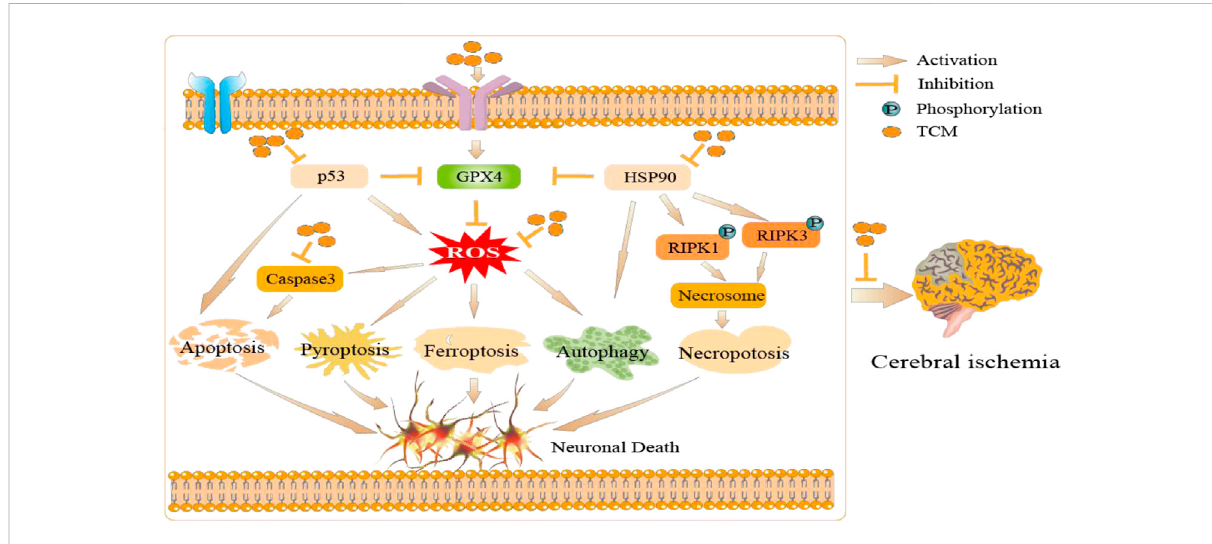
FIGURE 2 The potential applications of TCM in cerebral ischemia: TCM can regulate a variety of cell death pathways through ROS, HSP90, p53, and other molecular mechanisms, and thus play an anti-cerebral ischemia